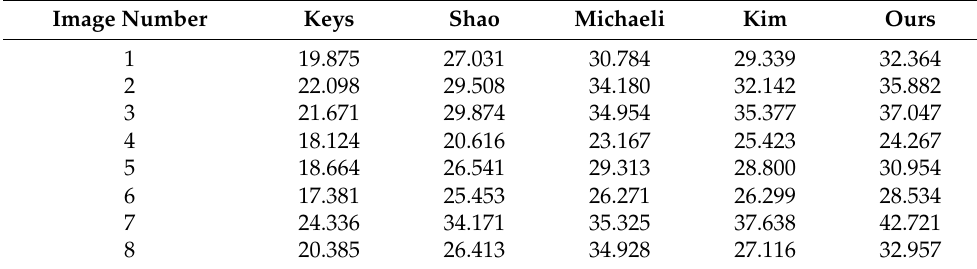
Figure 6. Different methods to reconstruct the real infrared image of No. 9: ( a ) real infrared image; ( b ) reconstruction results using the method in [35] (AG = 20.866; IE = 6.020); ( c ) reconstruction results using the method in [19] (AG = 29.275; IE = 6.212); ( d ) reconstruction results using the method in [17] (AG = 33.083; IE = 6.157); ( e ) reconstruction results using the method in [21] (AG = 30.449; IE = 6.188); ( f ) reconstruction results using our method (AG = 33.697; IE = 6.244). Table 1. Comparison of AG indexes of images reconstructed using different methods.